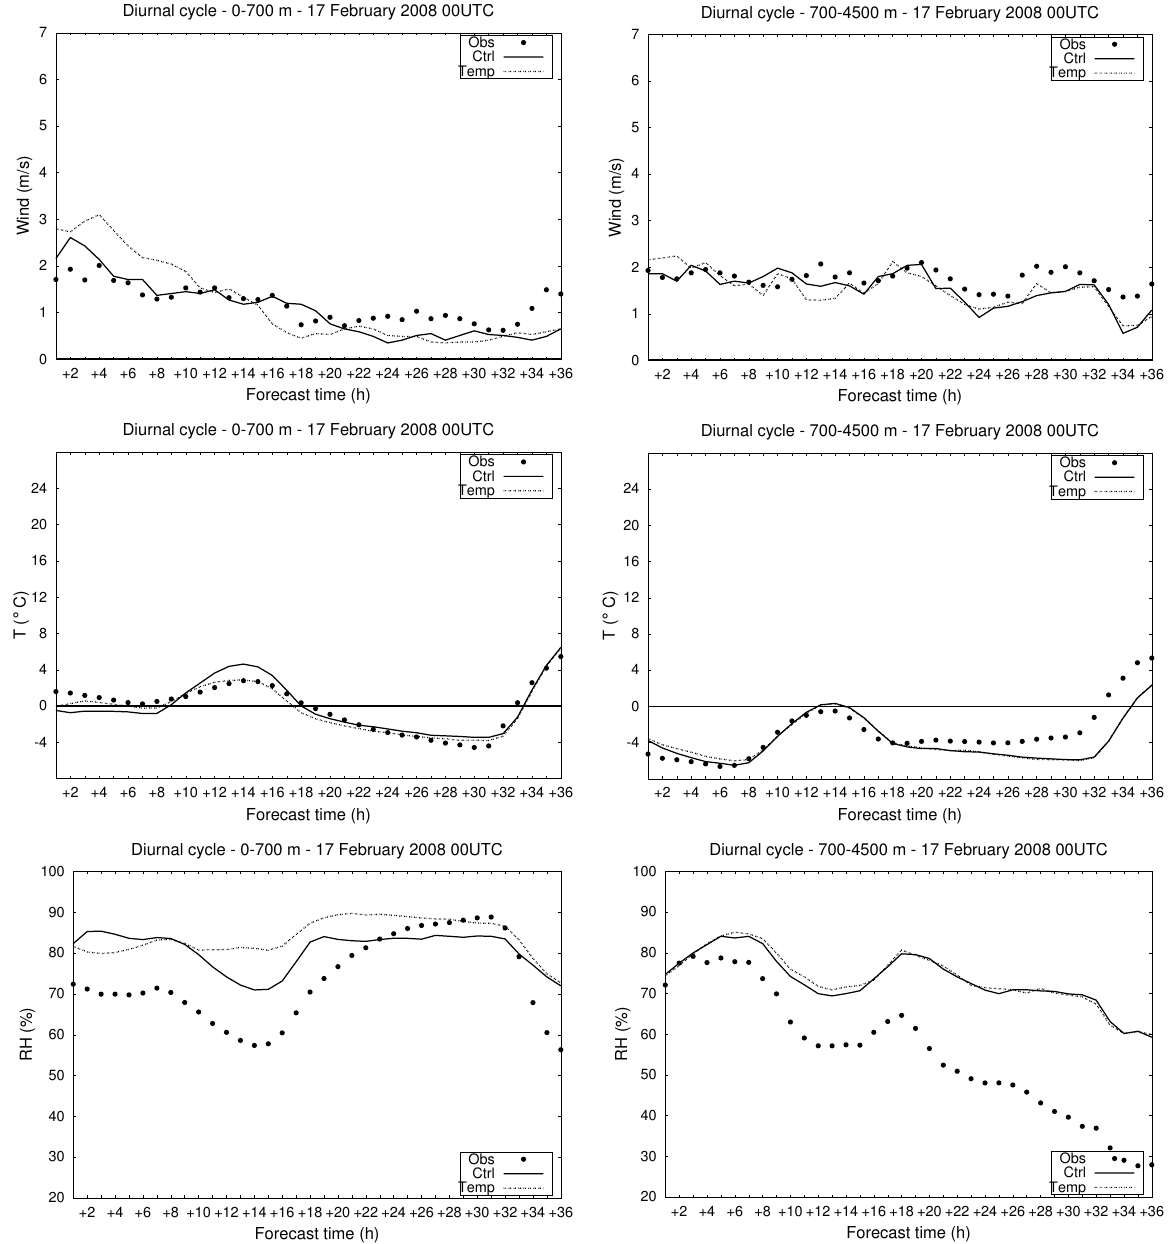
Fig. 10. Diurnal cycle for the February 2008 case, over the plains (left) and over the mountains (right); wind intensity (upper panels), temperature (middle panels) and relative humidity (bottom panels). The dots represent the Ctrl run and the dotted line represents the Temp run.